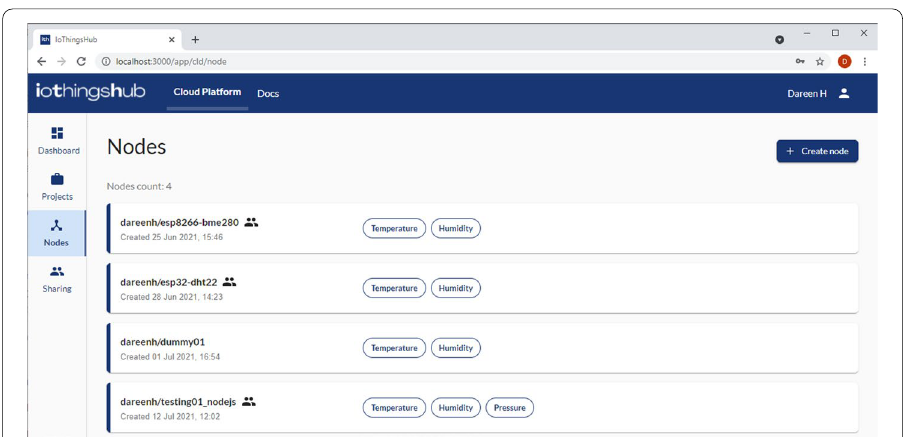
Fig. 11 IoThingsHub—list of nodes owned by a